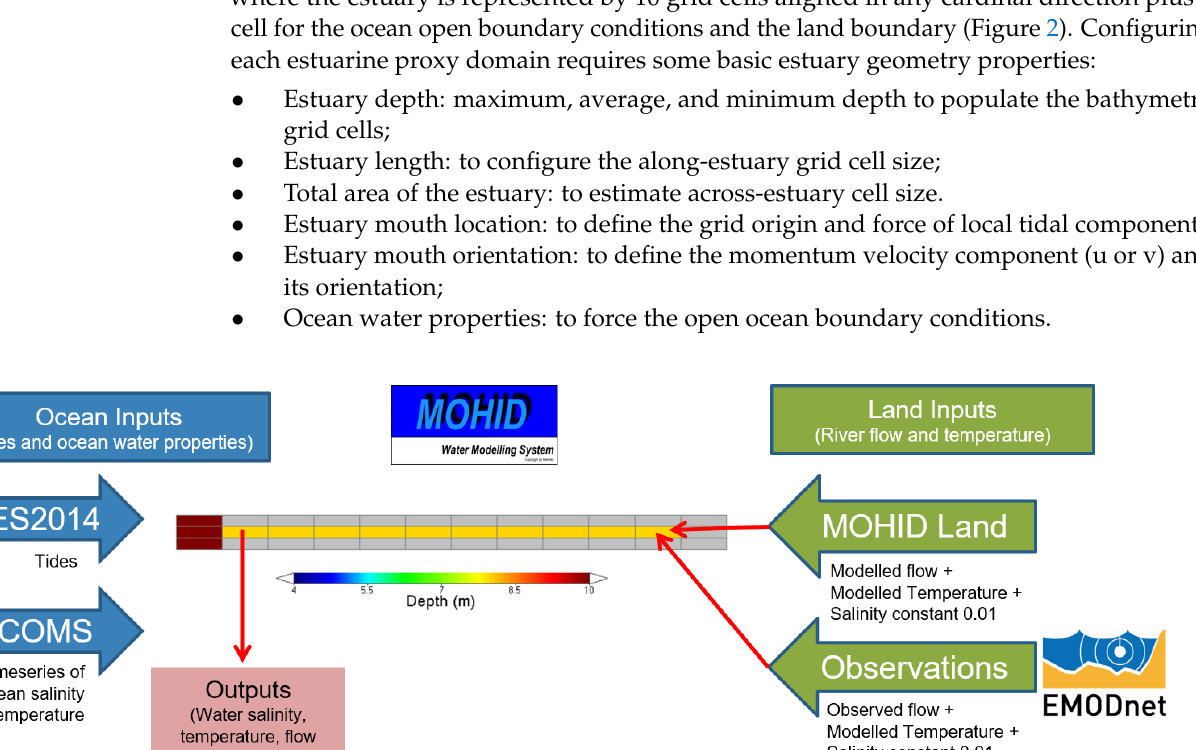
Figure 1. Topography and drainage network of the LAMBDA project watershed domains. The LAMBDA watershed domains are: ( a ) Western Iberian Peninsula domain; ( b ) Western France do- main; ( c ) Seine River domain; ( d ) Somme, Scheldt, and Meuse rivers domain; ( e ) Rhine River do- main; ( f ) Northwest Germany domain; ( g ) Elbe River domain; ( h ) Denmark domain; ( i ) Southern Norway domain; ( j ) United Kingdom and Ireland domain.